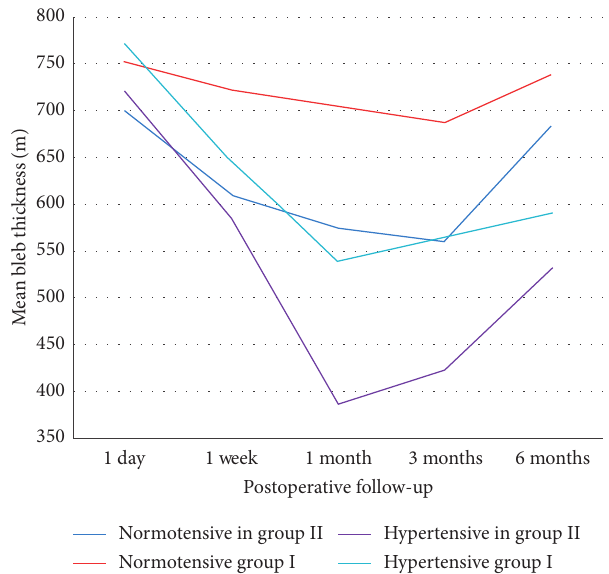
Figure 1: U-shaped pattern of the mean maximal bleb wall thickness.